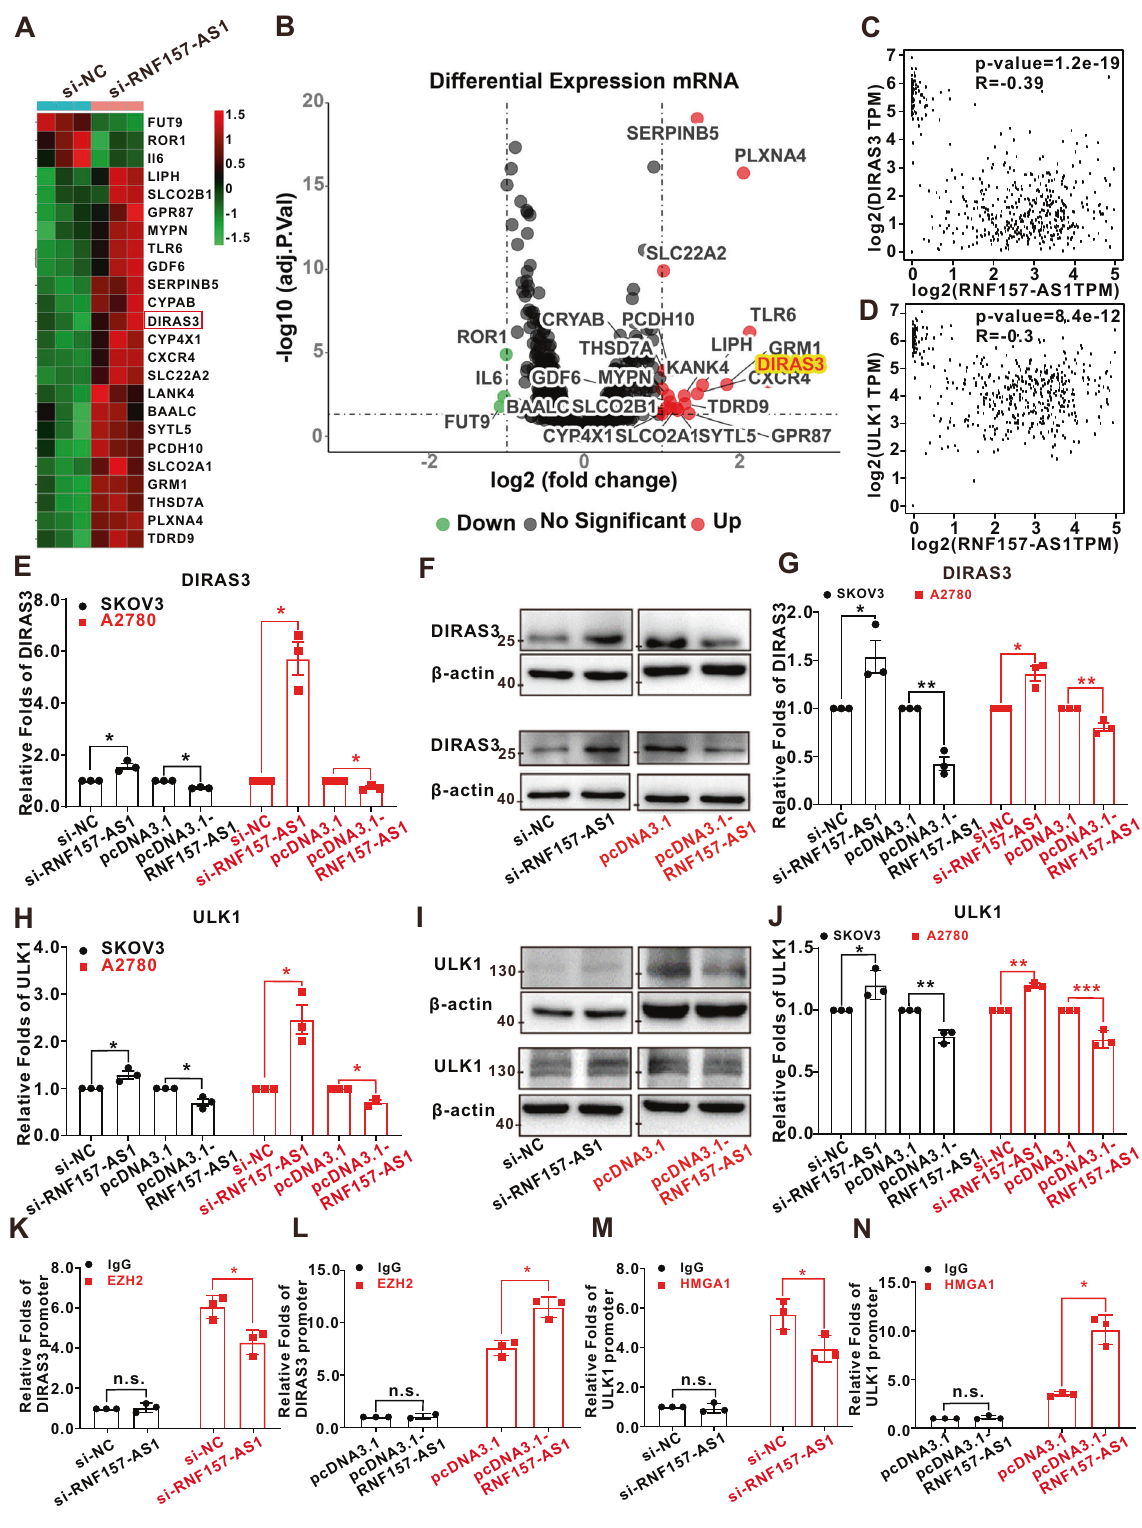
the binding of EZH2 to the promoter of DIRAS3 and the binding of HMGA1 to the promoter of ULK1 while overexpression of RNF157-AS1 increased the binding of EZH2 to the promoter of DIRAS3 and the binding of HMGA1 to the promoter of ULK1 (Figs. 4K – N and